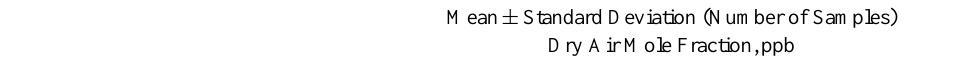
Table 7. WGC Picarro